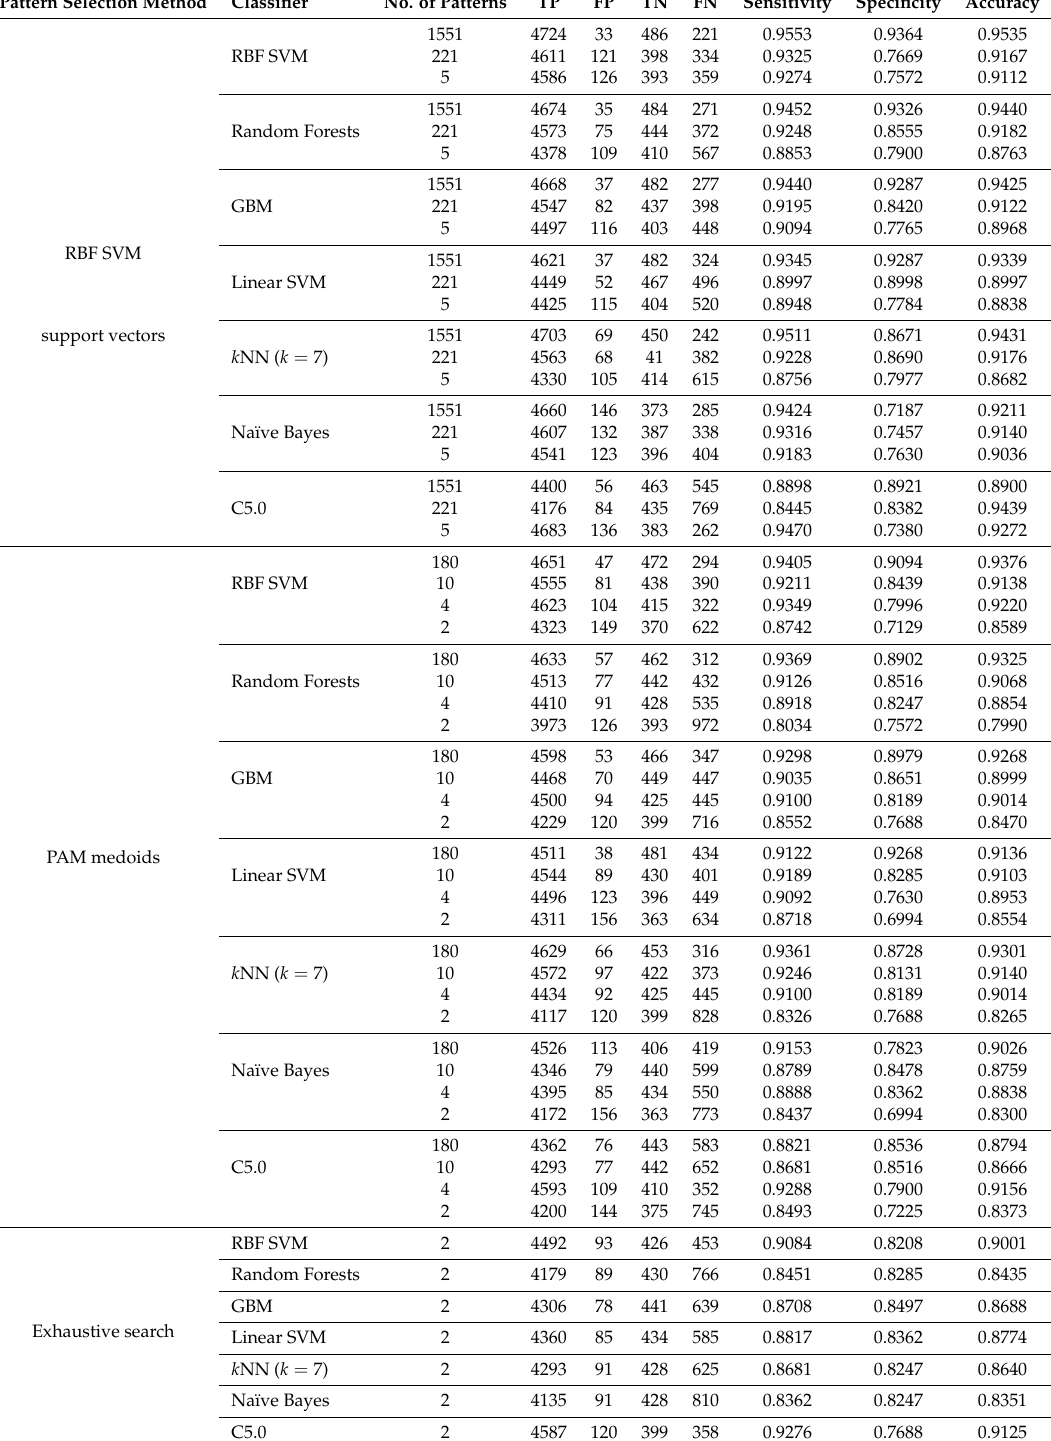
Table 4. Summary of results using the shape-based proposal with different